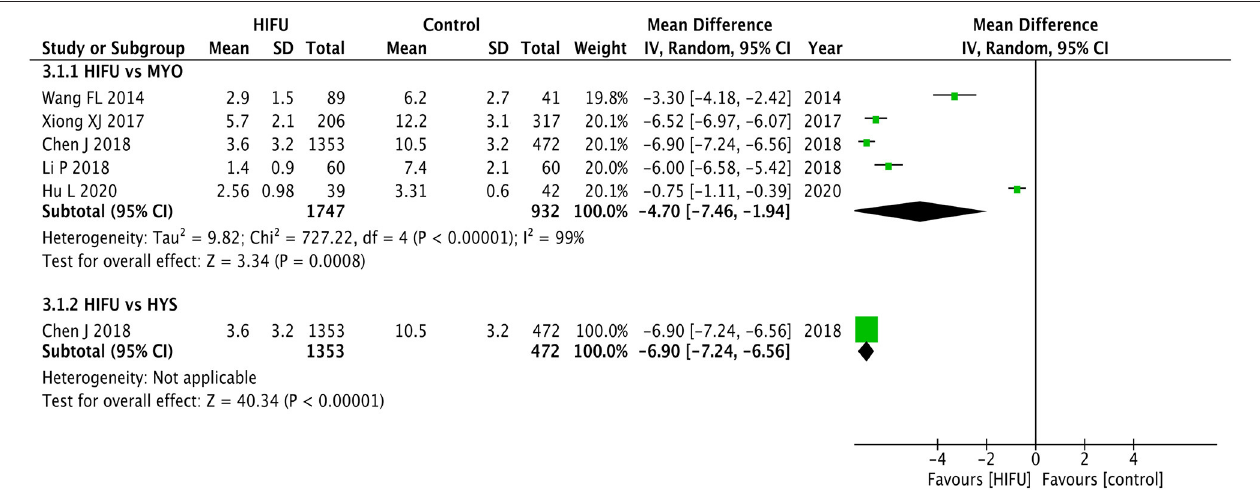
FIGURE 4 | Hospital stay of HIFU in comparison with other techniques.